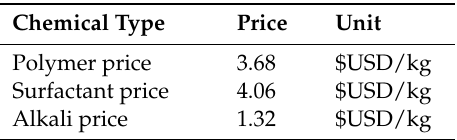
Table 3. Chemical costs.